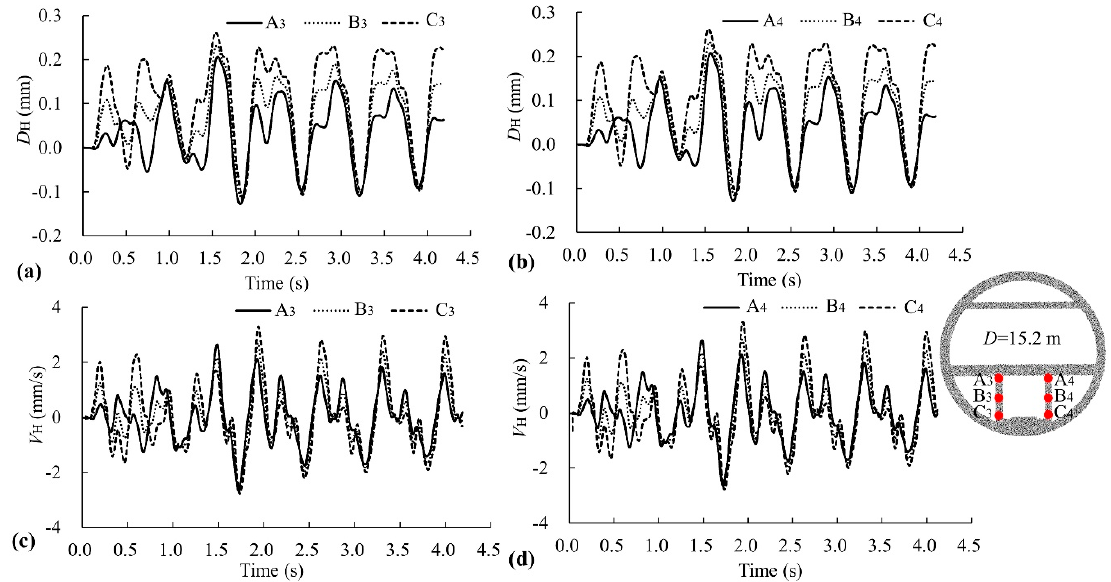
Figure 12. Horizontal displacement and velocity of Wall_3 and Wall_4 in T2: ( a ) D H of Wall_3; ( b ) D H of Wall_4; ( c ) D V of Wall_3; and ( d ) D V of Wall_4.